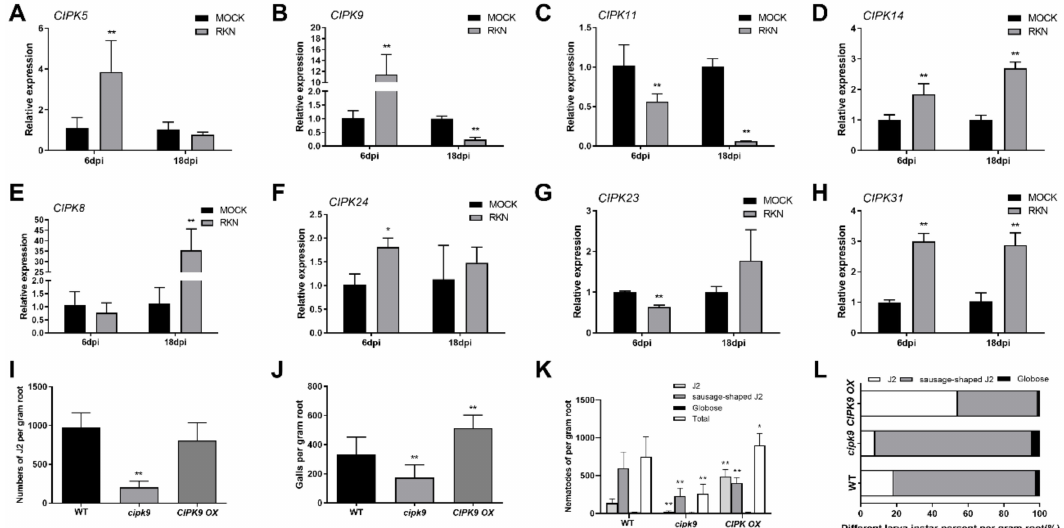
Figure 5. Altered disease resistance of cipk9 and CIPK9 OX plants against RKNs. ( A – H ) CIPK gene family expression. Error bars indicate the SD between biological repeats ( n = 3). ( I ) Numbers of second-stage infective juveniles (J2) inside roots on the cipk9 and CIPK9 OX plants at 6 d after RKN inoculation (SD, n = 16). ( J ) Numbers of root galls in the cipk9 and CIPK9 OX plants at 18 d after RKN inoculation (SD, n = 16). ( K , L ) Numbers and percentages of di ff erent larval instars on the cipk9 and CIPK9 OX plants at 18 d after RKN inoculation (SD, n = 16); * p < 0.05, ** p <